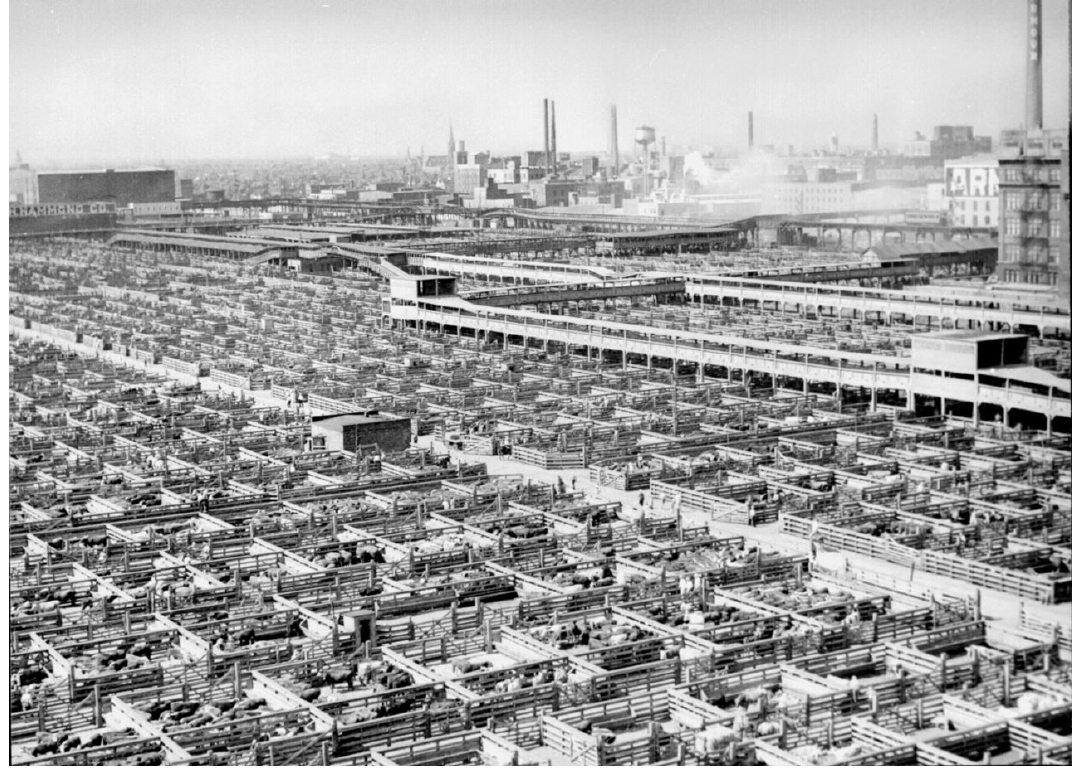
Figure 3: Union Stockyards, Chicago, 1947 Source: From an original unsigned film negative,